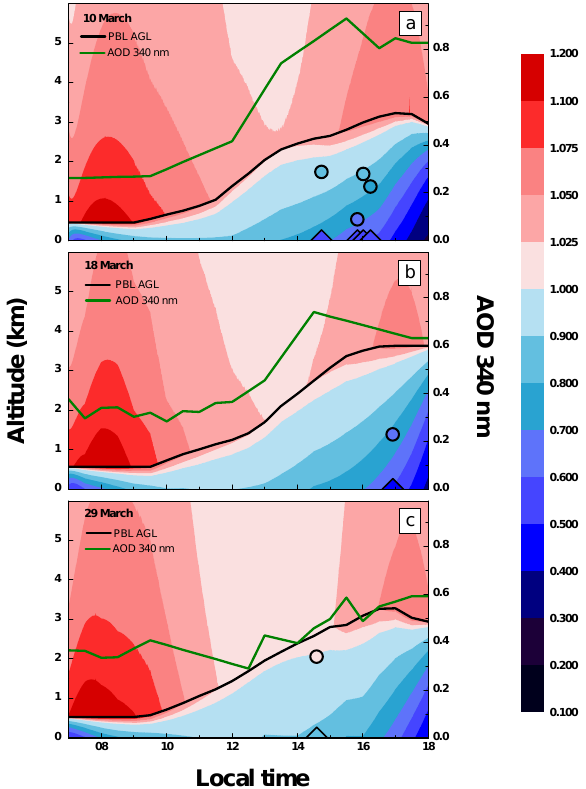
Fig. 8. Hourly variation of the ratios between polluted (only aerosols) and clear-sky total actinic flux model calculations for 10, 18, and 29 March 2006 at all altitudes below 6km (a.g.l.). Circles represent ratios between C-130 observations and clear-sky model calculations. Triangles represent ratios between surface observa- tions and clear-sky model calculations. Red tones show enhance- ments while blue tones show reductions with respect to clear-sky